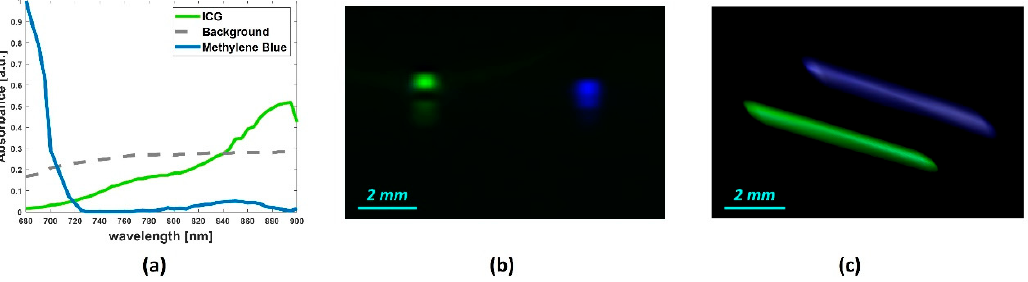
Figure 5. ( a ) Spectral absorption curves of the detected source components by NNMF, from 2-D spectral PA images of the tissue-mimicking vessel phantom. The overlapped abundance 2-D maps ( b ) and 3-D maps ( c ) of the detected source components: ICG and MB.